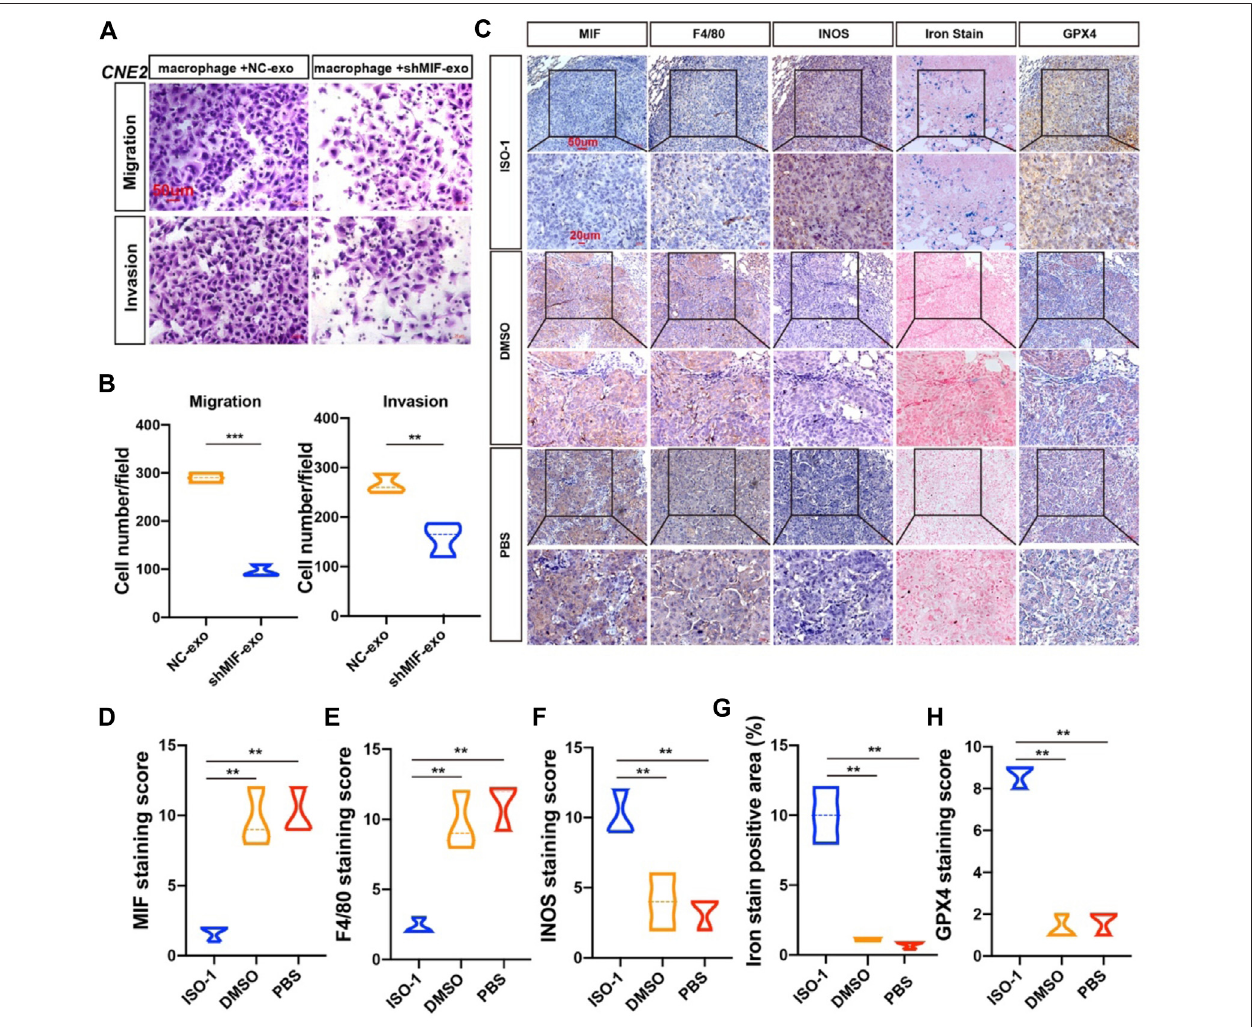
FIGURE 7 | MIF inhibits ferroptosis of macrophages and promotes metastasis in vivo . (A) Collect the control group and the exosomes secreted by CNE2 transfectedwithknockdownMIFtoco-culturewithmacrophages,collectthesupernatantofthemacrophages,andthenperformthemigrationandinvasionexperiments of CNE2. Scale bar:50 um. (B) Quanti fi cation of migration and invasion (t test). All graphs show the mean ± SEM of at least three independent experiments. * p < 0.05, ** p < 0.01,*** p < 0.001. (C) IHCanalysisoftherelationshipbetweenMIFand ferroptosisinthelungsofnudemice. (D – H) Quanti fi cationofIHC stainingforMIF (D) , F4/80 (E) , INOS (F) , Iron stain (G) and GPX4 (H) , INOS: marker of M1 macrophages. F4/80: marker of total macrophages. Expression using one-way ANOVA (** p < 0.01).